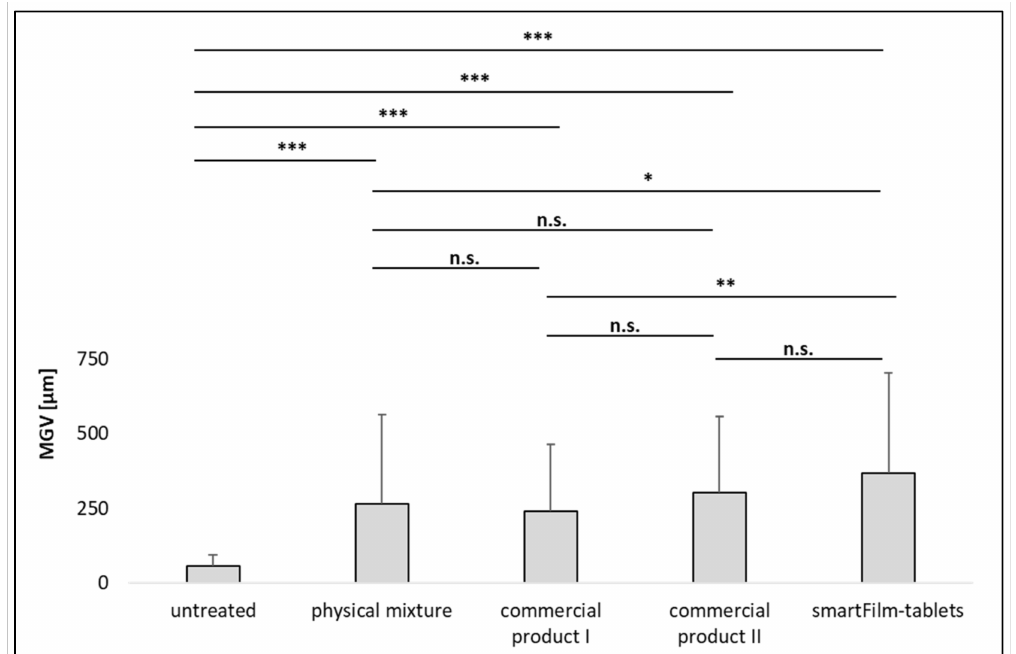
Figure 8. Mean permeation depth of curcumin from different formulations. (n.s.—nonsignificant, * p < 0.05, ** p < 0.01, *** p <